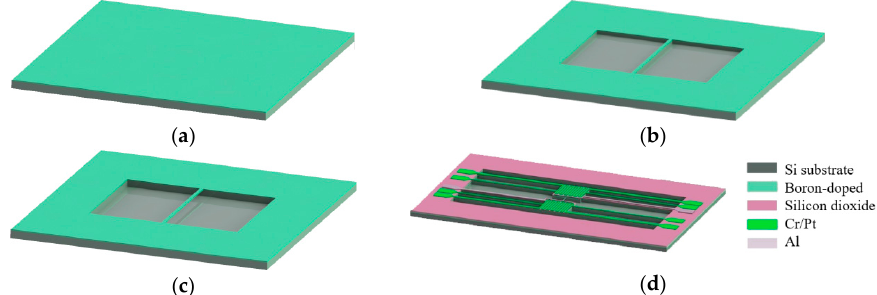
Figure 1. ( a ) Heavily boron-doped diffusion layer formed on the surface; ( b ) nanowire structure patterned by EBL and anisotropic ICP etching; ( c ) suspended Si nanowire released using TMAH solution; ( d ) schematic diagram of a thermoelectric structure using Si